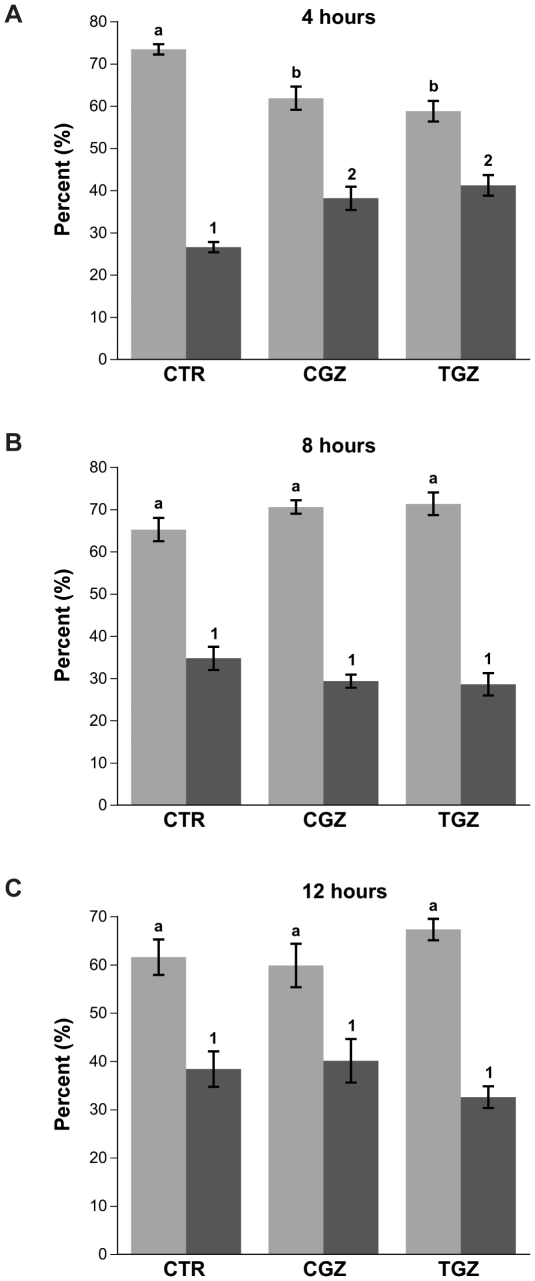
Annexin V assay to detect apoptosis in Ovcar3 cells.Ovcar3 cells were serum starved for 24 hours and treated with vehicle control (DMSO) or 10 µM of CGZ or TGZ for (A) 4 hours, (B) 8 hours, or (C) 12 hours. Results are the means ± SEM of 3 measurements from three individual experiments. Light gray bars represent viable cells; dark gray bars represent cells undergoing early and late apoptosis as well as those that are dead. Bars that do not share a letter or number designation are significantly different (p<0.05).